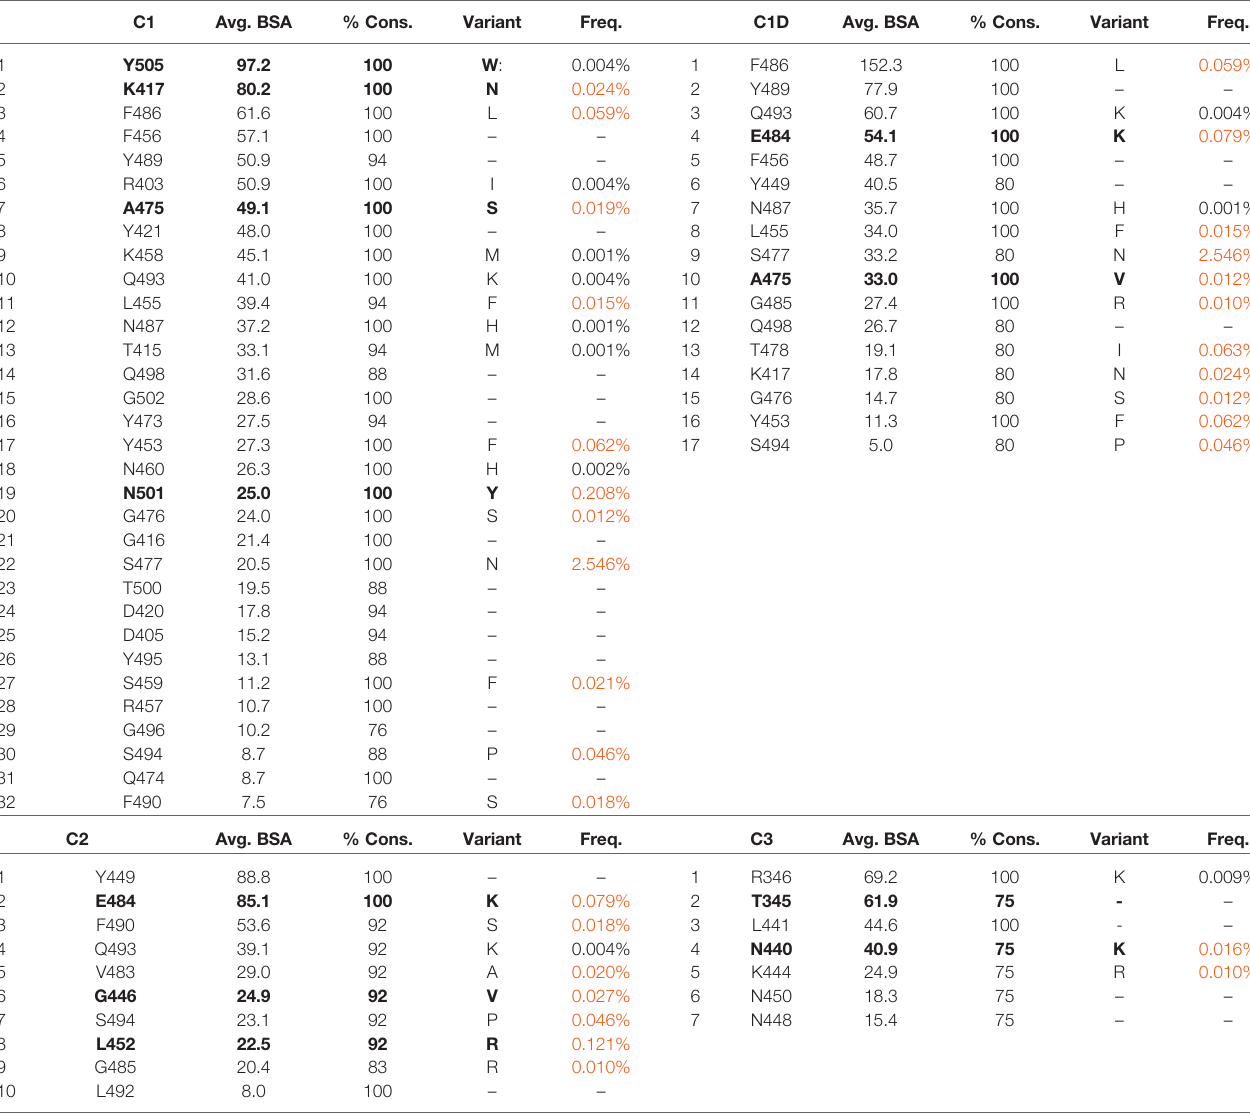
TABLE 2 | SARS-CoV-2 RBD residues conserved in ≥ 75% of NAb epitopes and the frequencies of